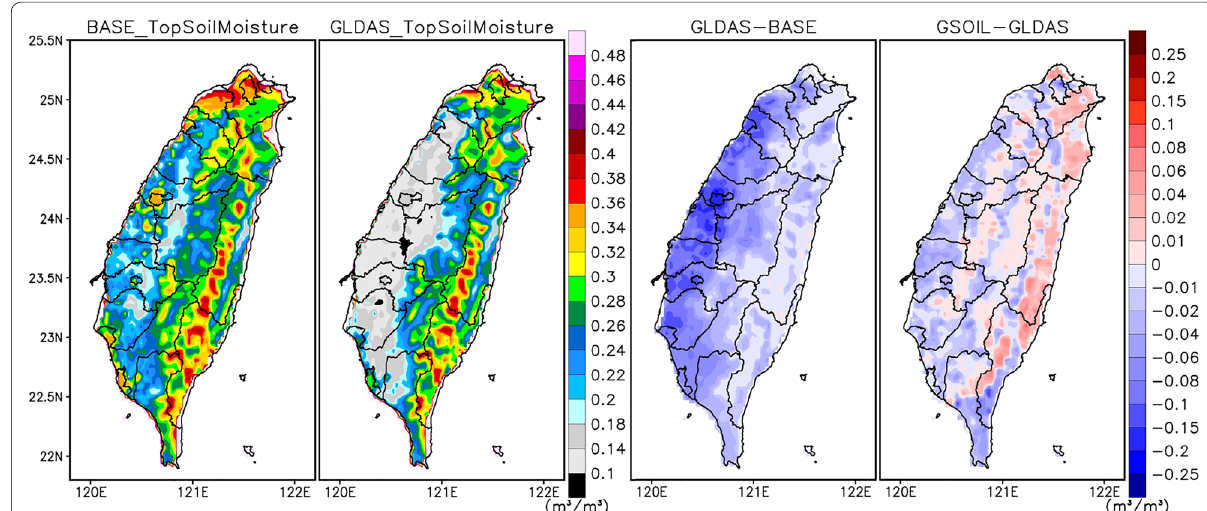
Fig. 5 Top‑layer (0–10 cm) soil moisture (m 3 m − 3 ) averaged for 6‑month simulation. Left to the right are from WRF‑base, WRF‑GLDAS, difference between WRF‑GLDAS and WRF‑base, and difference between WRF‑GSOIL and